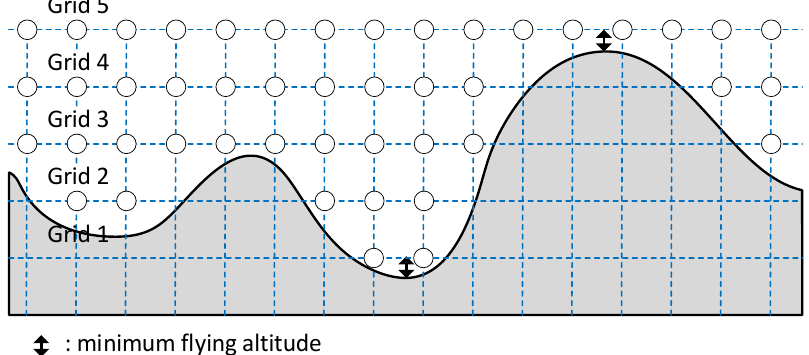
Figure 5. Five grids positioned above the 3D terrain.